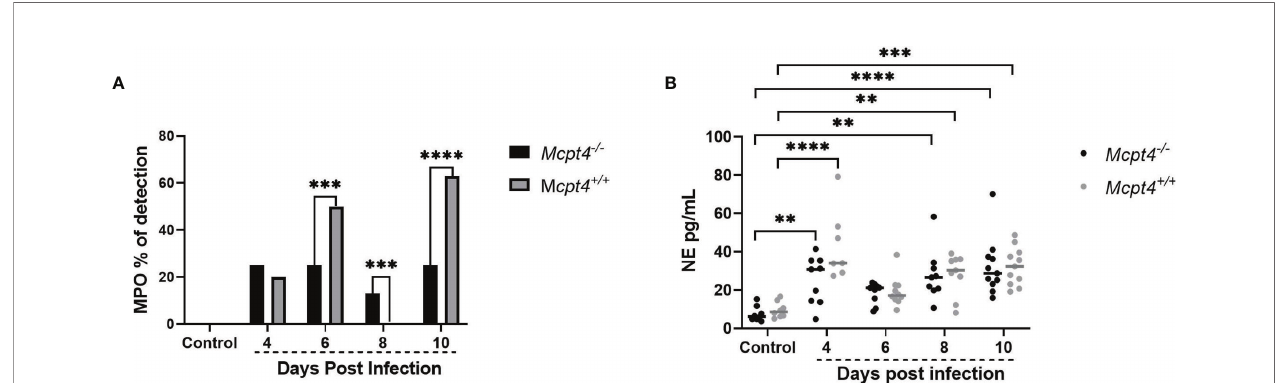
FIGURE 4 | Mcpt4 -/- mice exhibited signi fi cantly decreased neutrophil activation at 6 and 10 days following P. y. yoelii 17XNL infection. (A) Plasma myeloperoxidase (MPO) detection by ELISA, represented as percentage of positive plasma samples at 4, 6, 8, and 10 days PI. (B) Plasma neutrophil elastase (NE) as determined by ELISA. MPO and NE were determined for the three biological replicates (n=11 mice per group per time point). MPO data were analyzed with Fisher ’ s exact test and NE data were analyzed with the Kruskal-Wallis test followed by Dunn ’ s multiple comparison for each time point versus control or between Mcpt4 -/- and Mcpt4 +/+ mice at speci fi c time points. P values ≤ 0.05 were considered signi fi cant. **P ≤ 0.01; ***P ≤ 0.001, ****P ≤